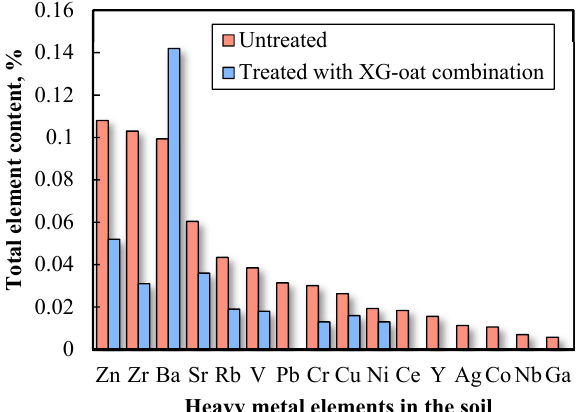
Figure 17. XRF analysis of the heavy metal elements of the untreated soil and the soil treated with the 0.25% XG–oat combination (pH = 7).